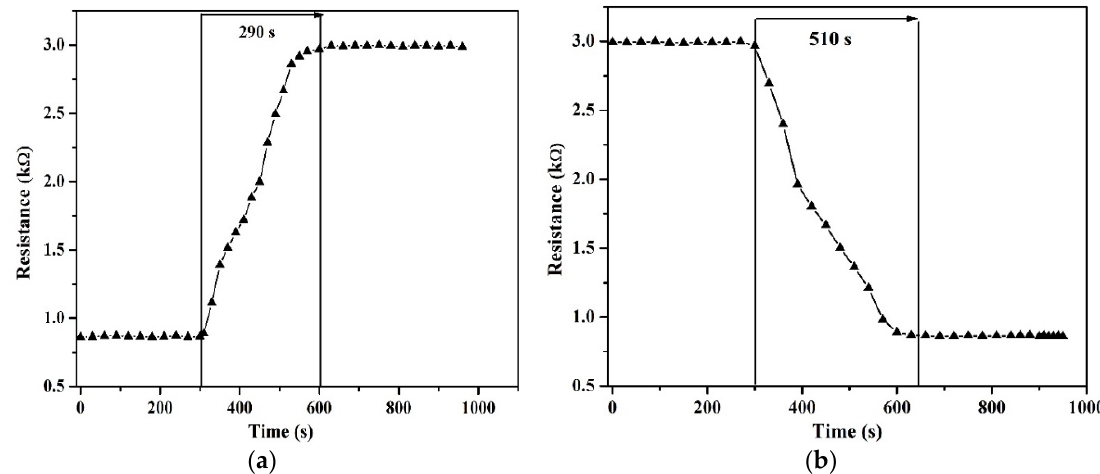
Figure 5. ( a ) Rise time and ( b ) fall times of suspended carbon nanotubes. The humidity was varied from 15% to 98% in steps of 10% RH increases every 20 s.